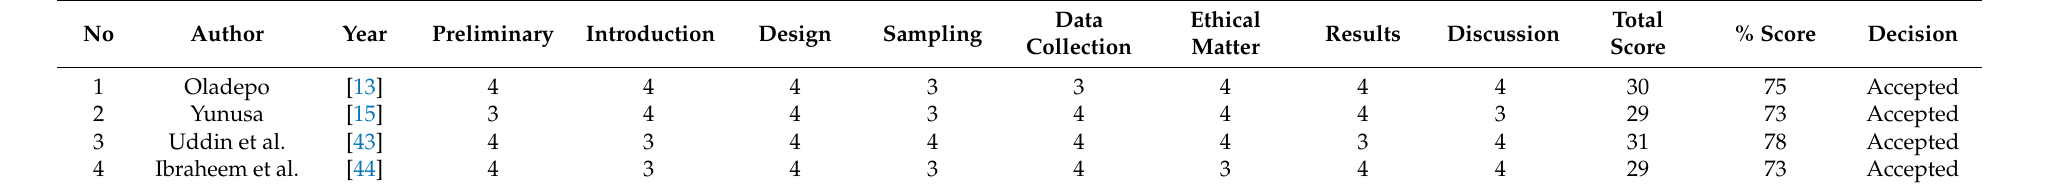
Table 3. Crowe critical appraisal for quasi-experimental